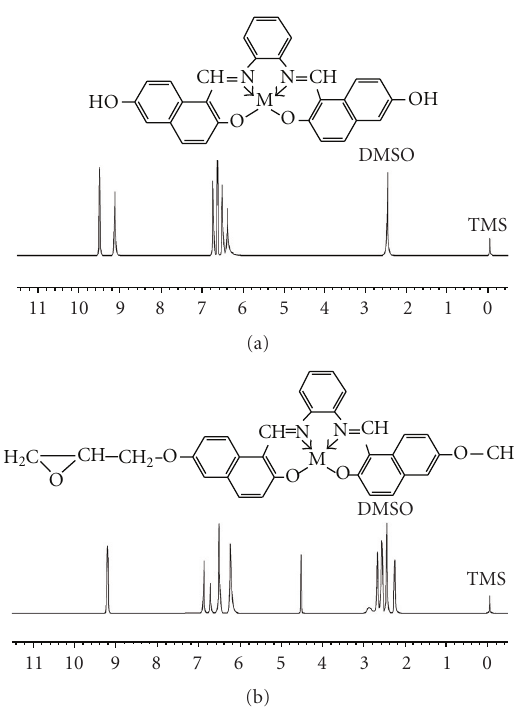
Figure 2: 13 C-NMR spectra of (a) (ZnL) Schi ff base complexes and (b) Zn chelated epoxy